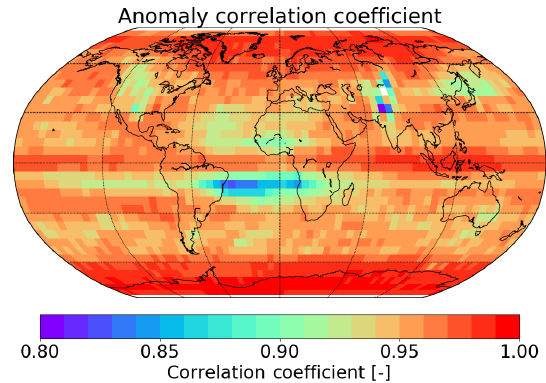
Figure 10. Correlation coefficient between adjusted MERRA-2 and GTO-ECV ozone